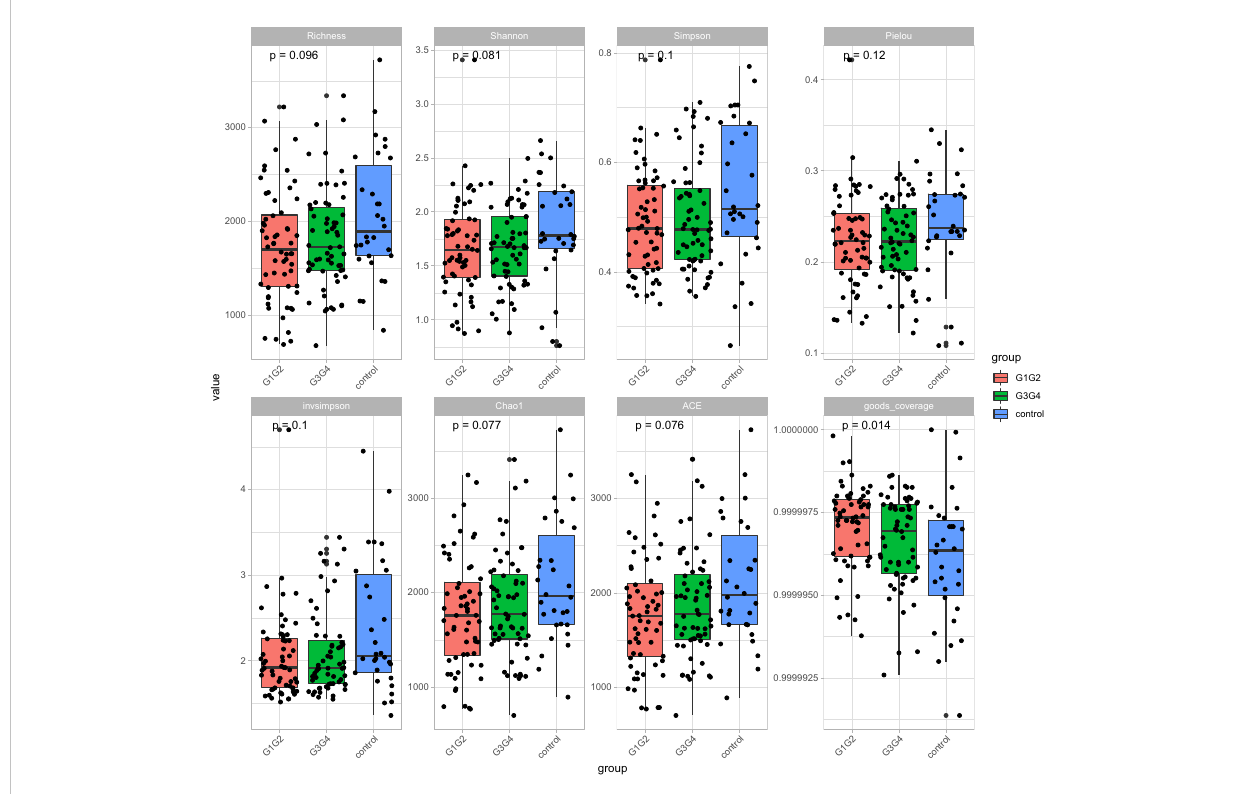
FIGURE 1 Alpha diversity indices included Richness, Shannon, Simpson, Pielou, invsimpson, Chao1, ACE, and goods coverage. The Alpha diversity index was plotted as a cumulative box plot of species to assess differences in species richness and diversity of microbial communities among the control, G1G2 and G3G4